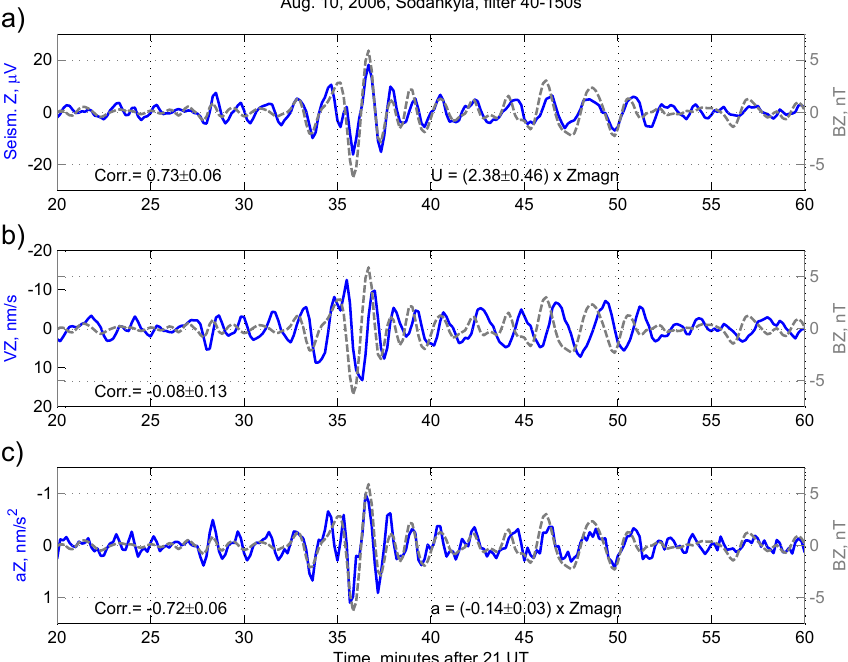
Fig. 4. Comparison of shape of signal of Pi2 geomagnetic pulsations recorded by the magnetometer in Sodankyl¨a to the shape of the same event recorded by the STS-2 seismometer: (a) shows comparison of the magnetometer signal to the voltage at the seismometer output; (b) shows comparison of the magnetometer signal to ground velocity; (c) shows comparison of the magnetometer signal to ground accelera- tion.